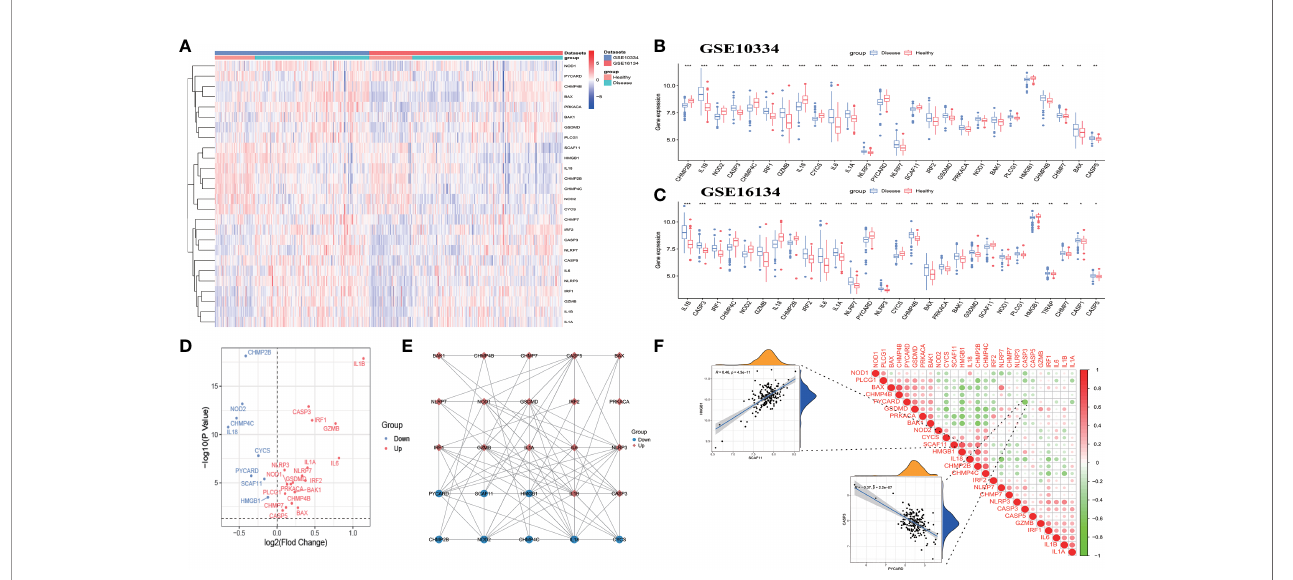
FIGURE 2 | Identi fi cation of differentially expressed pyroptosis-related genes (DE-PRGs) in periodontitis. (A) Heat map of 26 DE-PRGs in the periodontitis dataset (GSE10334 and GSE16134). (B, C) The box plots show the different expression levels of the 26 PRGs between disease (periodontitis) and healthy samples in the GSE10334 dataset (B) and GSE16134 dataset (C) . * P < 0.05, ** P < 0.01, *** P < 0.001. (D) Volcano plot of the 26 DE-PRGs in the GSE10334 dataset. (E) Protein – protein interaction (PPI) network of the 26 DE-PRGs. (F) Correlations of the 26 DE-PRGs in the periodontitis samples Red, positive correlation; Green, negative correlation. The color depth and the size re fl ect the strength of the relevance. The strongest positive and the strongest negative correlation were displayed in scatter